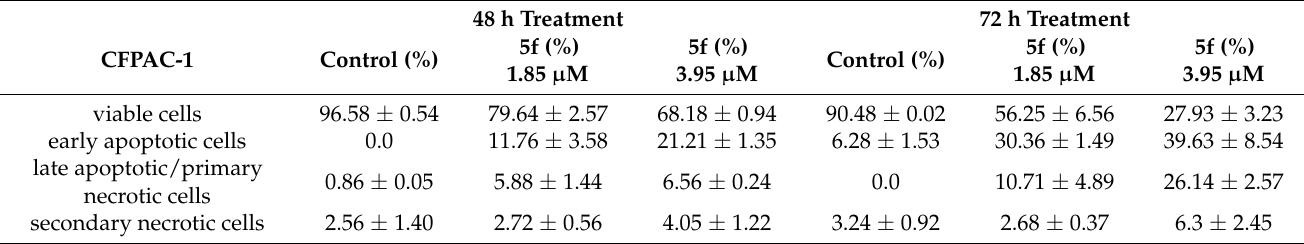
Table 3. Annexin V assay for apoptosis detection in CFPAC-1 cells 1 .